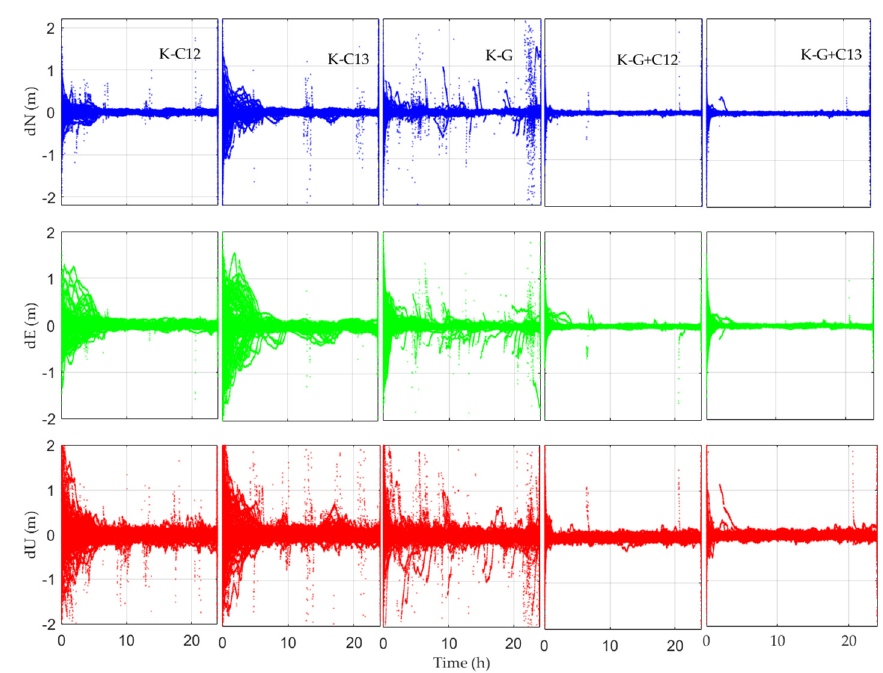
Figure 8. Kinematic PPP error series for 20 days at 17 stations utilizing GBM’s precise orbit/clock corrections (the result after the abnormal data are raised).